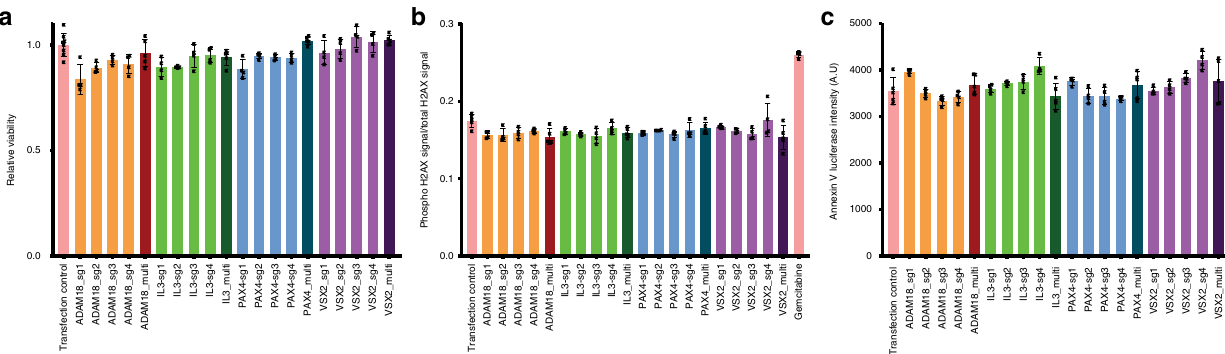
Fig. 4 Genotoxicity with AsCpf1-based multiplexed genome editing Cells were transfected with AsCpf1 – 3xMYC plasmid together with either mono- cistronic guides or multiplexed guide arrays targeting non-essential genes. Each multiplexed guide array contains four different mono-cistronic guides used in this study. For example, ADAM18_multi contains 4 different guides ADAM18_sg1, ADAM18_sg2, ADAM18_sg3, and ADAM18_sg4. a Relative viability of cells treated by AsCpf1 and different single guide vectors or multiplexed guide vectors. n = 8 for transfection control, n = 4 for all mono-cistronic vectors, n = 5 for all multiplexed vectors. Error bars are present as s.d. b Phosphorylated H2A.X signal of cells treated by AsCpf1 and different single guide vectors or multiplexed guide vectors. Gemcitabine: 1-hour 100 nM gemcitabine treatment prior to In-cell Western assay as a positive control. n = 4 for all mono- cistronic vectors, n = 5 for all multiplexed vectors and transfection control. Error bars are present as s.d. c Annexin-V staining signal of cells treated by AsCpf1 and different single guide vectors or multiplexed guide vectors. n = 4 for all mono-cistronic vectors, n = 5 for all multiplexed vectors and transfection control. A.U. arbitrary units. Error bars are present as s.d. Source data are provided as a Source Data fi